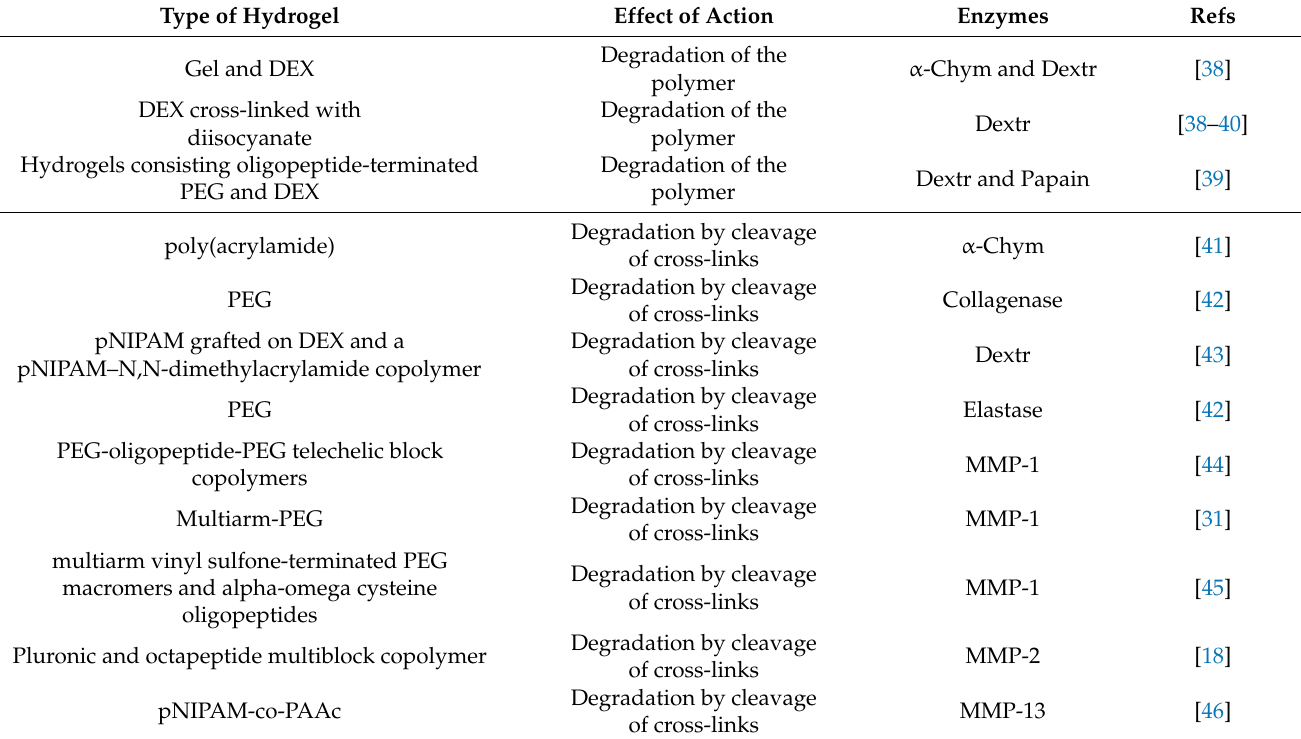
Table 2. Enzyme-responsive biomedical